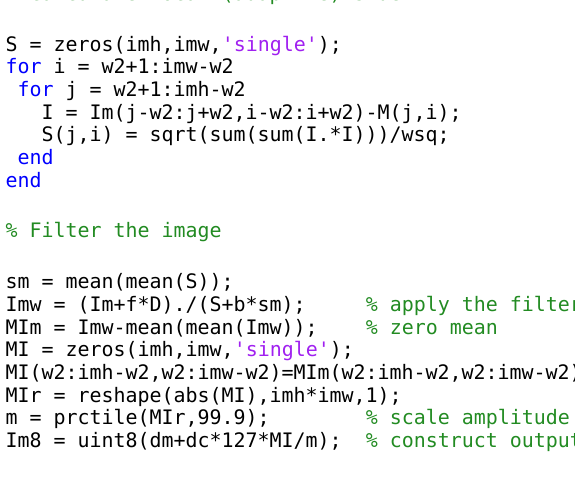
Figure 11. Matlab code for local contrast enhancement filter, based on the Wallis filter.